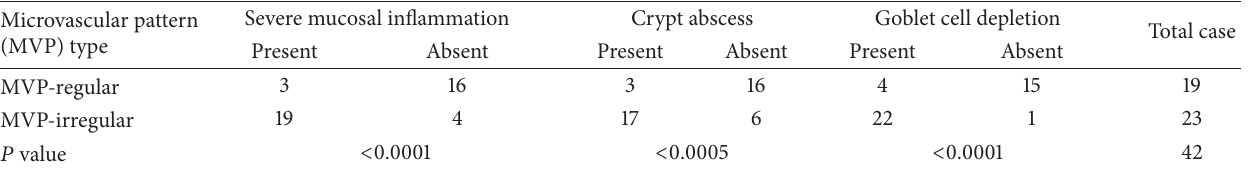
Table 4: Narrow band imaging-guided magnifying endoscopic findings of microvascular pattern (MVP) and pathognomonic histological features of ulcerative